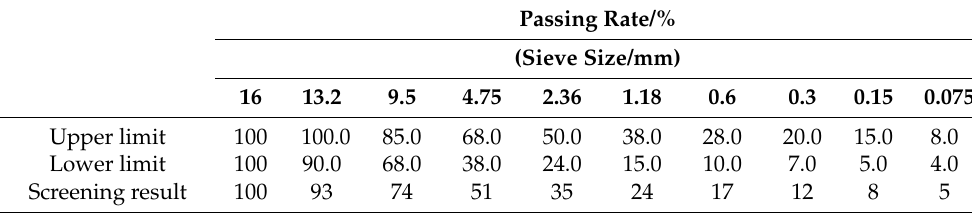
Table 2. Gradation of AC-13 asphalt